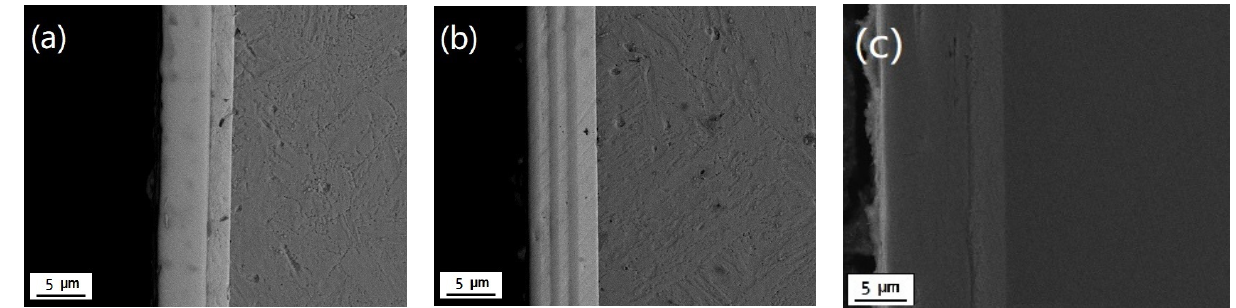
Figure 5. Cross-sectional micrograph of ZrN coatings with three structures. ( a ) Coating #1 single layer, ( b ) Coating #2 multilayer, ( c ) Coating #3 gradient layer.